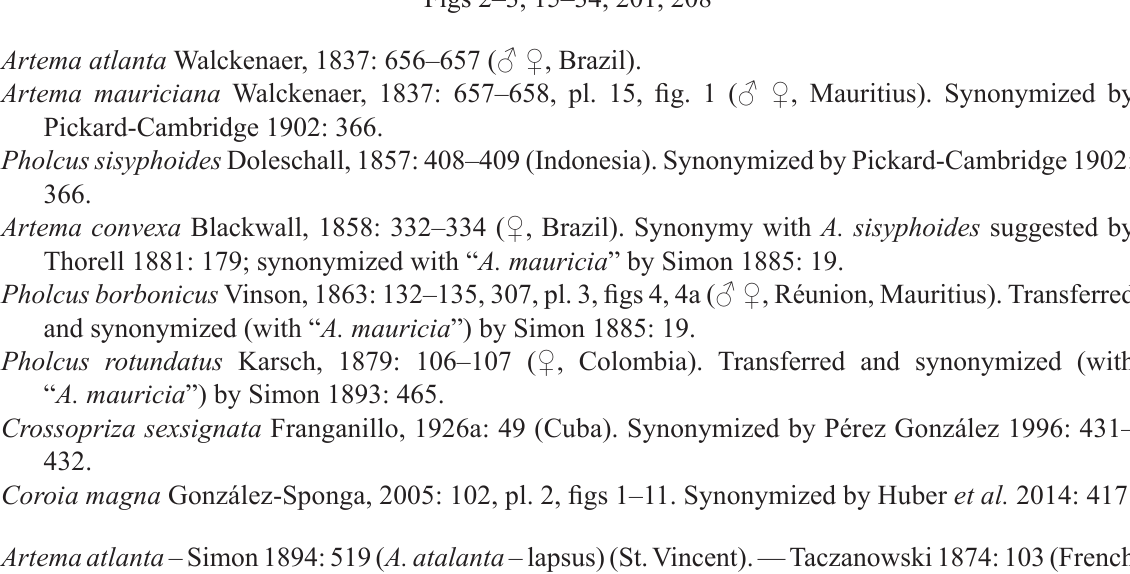
2. Epigynal plate rectangular, without dark median sclerite and without prominent pale median – Epigynal plate different, either with dark median sclerite and/or prominent pale median area …3 3. Epigynal plate posterior margin strongly indented (Fig. 15) …… Artema atlanta Walckenaer, 1837 – Epigynal plate posterior margin either straight (Figs 46, 105), gently indented (Figs 135, 143) or 4. Anterior epigynal projections (AEP) distinctively prominent and pointed (cf. Huber & – 5. Epigynal plate ~2.5 × wider than long; median posterior margin distinctively protruding (Fig. 169) – 6. Epigynal plate with long dark median sclerite fused at posterior epigynal margin with lateral – Epigynal plate long with dark median sclerite not fused at posterior epigynal margin with lateral sclerotized plates (Figs 45–50, 103–114, 195–199) ………………………………………………7 7. Epigynal plate pale median area very inflated and prominent (Figs 195–200) …………………… – 8. Epigynal plate posterior margin almost straight, gently undulating. Pale median area with distinct dark median sclerite ⅓–½ the length of epigynal plate (Figs 45–50) …… Artema nephilit sp. nov. – Epigynal plate trapezoidal, i.e., wider posteriorly; pale median area slightly inflated posteriorly; dark median sclerite ⅓–⅔ the length of epigynal plate; dark median sclerite not fused at